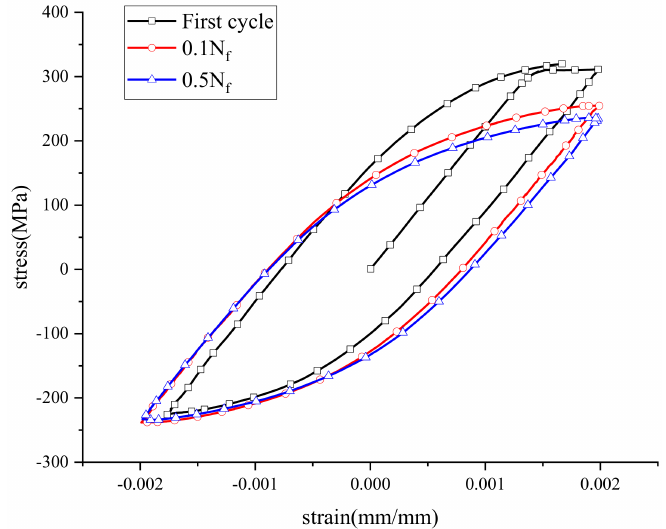
Figure 5. Effect of pre − strain on the hysteresis